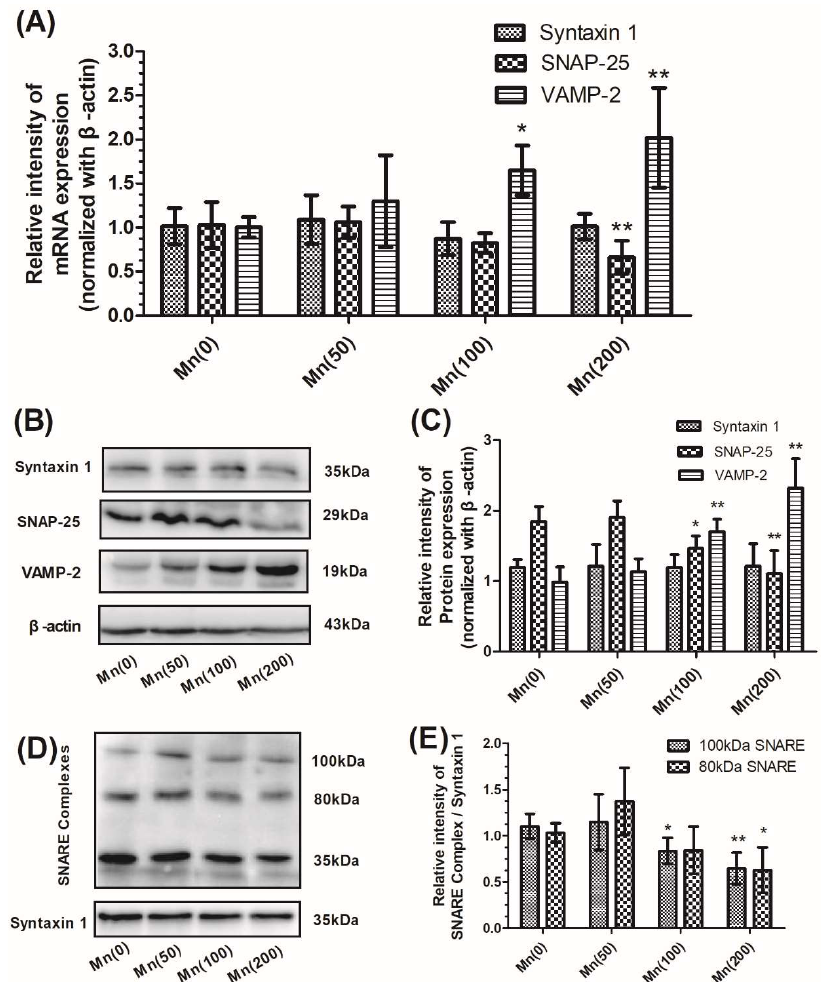
Figure 2. Mn disturbed the expression of syntaxin 1, SNAP-25, and VAMP-2, and reduced SNARE complex formation, in SH-SY5Y cells. After cells were exposed to 0, 50, 100, and 200 µ M Mn for 24 h, the expression of syntaxin 1, SNAP-25, VAMP-2, and SNARE complexes were determined. ( A ) The mRNA expression of syntaxin 1, SNAP-25, and VAMP-2 normalized with β -actin. ( B ) The protein products of syntaxin 1, SNAP-25, VAMP-2, and β -actin. ( C ) Semi-quantitative analysis of the protein expression of syntaxin 1, SNAP-25, and VAMP-2 normalized with β -actin. ( D ) The protein products of the SNARE complex and syntaxin 1. Two major syntaxin 1-containing complexes were detected, migrating at 100 kDa and 80 kDa, respectively. ( E ) Semi-quantitative analysis of the expression of the SNARE protein complex (100 kDa and 80 kDa) normalized with syntaxin 1. Data represent mean ± standard deviation, n = 4. * p < 0.05 and ** p < 0.01 indicate significant differences from controls.